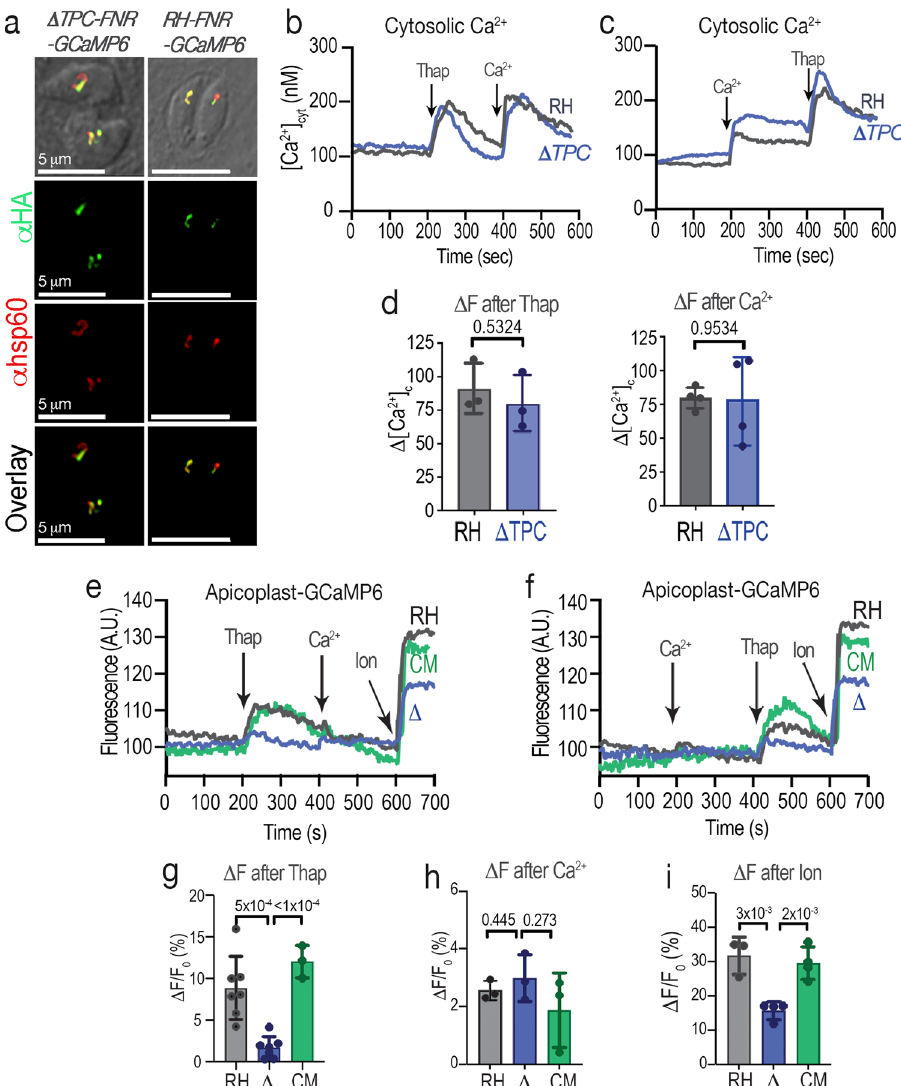
GCaMP6 parasites showing the localization of the Ca 2 + indicator with α HA ( green ) and its co-localization with the apicoplast marker Hsp60 ( red ). N = 3. b cytoplasmic Ca 2 + responses of Fura2-AM loaded parasites. The experiment shows the comparison between RH ( gray traces ) and Δ TPC ( blue traces) . Thapsigargin (Thap) and Ca 2 + were added at the times indicate. N = 3. c similar experiment to the one in b, with the additions reversed. N = 4. d quanti fi cation of the changes in fl uorescence ( Δ F slopes) after the addition of 1 µ M thapsigargin ( Δ F after Thap) or 1.8 mM Ca 2 + ( Δ F after Ca 2 + ). The response to these two additions is not signi fi cantly different between both cell lines. Δ F after Thap ( p = 0.5324, N = 3); Δ F after Ca 2 + ( p = 0.9534, N = 4). Data are presented as mean ± SD. e , f apicoplast GCaMP6f fl uorescence changes of RH-FNR-GCaMP6 (parental, RH), Δ TPC-FNR-GCaMP6 ( Δ ) and Δ TPC- TPC-FNR-GCaMP6 (complemented, CM) cells in response to the addition of 1 µ M Thap, 1.8 mM Ca 2 + or 1 µ M ionomycin (Ion). g Quanti fi cation of the Δ Fs after the fi rst addition of Thap. RH versus Δ ː p = 0.0005 and CM versus Δ ː p < 0.0001); RH: n = 7, N = 4; Δ : n = 7, N = 4; CM: N = 3. Data are presented as mean ± SD. h Quanti fi cation of the Δ Fs after the fi rst addition of Ca 2 + . RH versus Δ : p = 0.445; CM versus Δ : p = 0.273. RH: N = 3; Δ ː n = 7, N = 3; CM: N = 3. Data are presented as mean ± SD. i Quantif i cation of the Δ F after the addition of Ion from experiments similar to the ones in ( e , f ). RH versus Δ